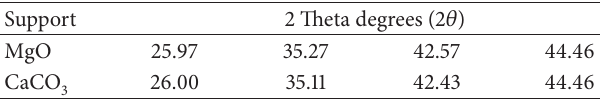
Table 2: Peaks obtained from X-ray diffraction of Fe/Co catalyst supported on magnesium oxide and calcium